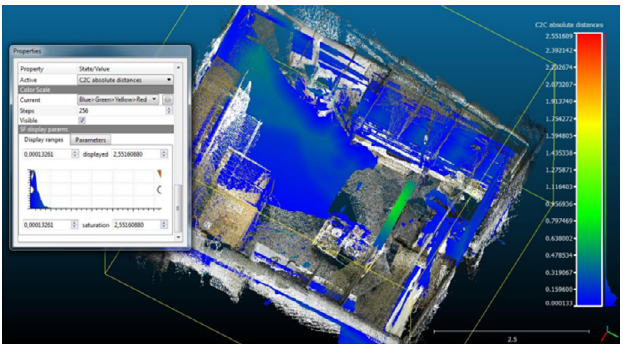
Fig. 17. Cloud-to-cloud distance